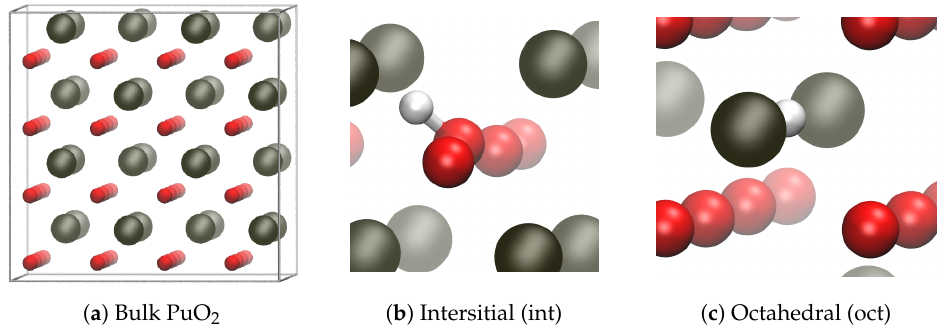
Figure 1. Snapshot of a 32 formula unit PuO 2 supercell, with zoomed in images of the interstitial (int) and octahedral (oct) hydrogen bulk absorption sites. Periodic boundaries for bulk PuO 2 are shown by the grey lines. Pu atoms are colored grey, oxygen atoms are red, and the hydrogen atom is